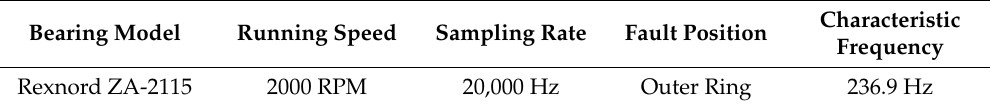
Figure 4. Bearing test rig and sensor placement [28]. Reproduced with permission from [28], Elsevier, 2019. Table 1. Experimental settings of case 1.